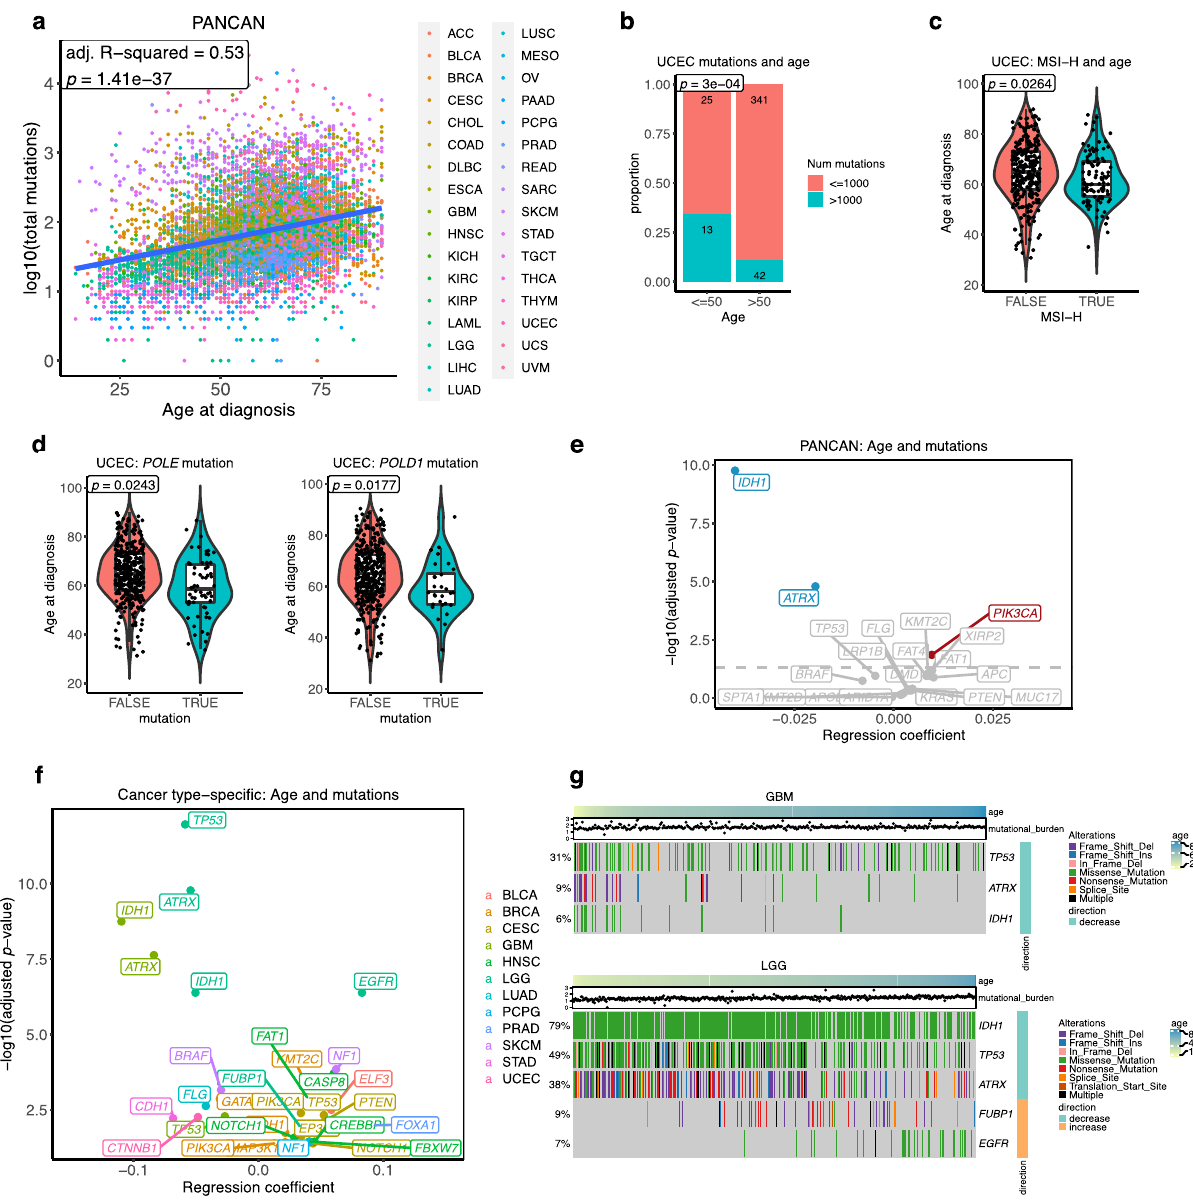
Fig. 4 Association between cancer patients ’ age and somatic mutations. a Association between patient ’ s age and mutation burden in pan-cancer. Adjusted R-squared and p value from multiple linear regression analysis are presented. Multiple-hypothesis testing correction was not performed (single test). b The proportion of hypermutated tumours (>1000 mutations/exome) in young (age ≤ 50) and old (age > 50) UCEC. The statistical signi fi cant ( p value) was calculated using two-sided Fisher ’ s exact test. c The association between age and MSI-H in UCEC. FALSE n = 286, TRUE n = 106 samples. The statistical signi fi cance ( p value) was calculated from the multiple logistic regression adjusting for clinical variables. d The association between age and POLE/POLD1 mutations in UCEC. POLE FALSE n = 359, TRUE n = 62 samples. POLD1 FALSE n = 392, TRUE n = 29 samples. The statistical signi fi cance ( p value) was calculated from the multiple logistic regression adjusting for clinical variables. The middle bar of the boxplot is the median. The box represents interquartile range (IQR), 25 – 75th percentile. Whiskers represent a distance of 1.5 × IQR. e A pan-cancer association between age and mutations. Multiple logistic regression coef fi cient and signi fi cant values are shown. Multiple-hypothesis testing correction was done using Benjamini – Hochberg procedure. Genes with a signi fi cant positive and negative association between age and somatic mutations after using multiple logistic regression (adj. p value < 0.05) are highlighted in red and blue, respectively. f Summary of the cancer type-speci fi c association between age and mutations. Multiple logistic regression coef fi cient and signi fi cant values are shown. Multiple-hypothesis testing correction was done using Benjamini – Hochberg procedure. Only genes with a signi fi cant association (adj. p value < 0.05) are shown in the fi gure. A colour code is provided to denote the cancer type where the association between age and gene mutation was found. g Heatmap showing age-associated mutations in GBM and LGG. Samples are sorted by age. Colours represent types of mutation. The right annotation legend indicates the direction of change, increase or decrease mutations with age. The mutation burden of samples is presented in the dot above the heatmap. TCGA cancer type acronyms and their associated name are provided in Table